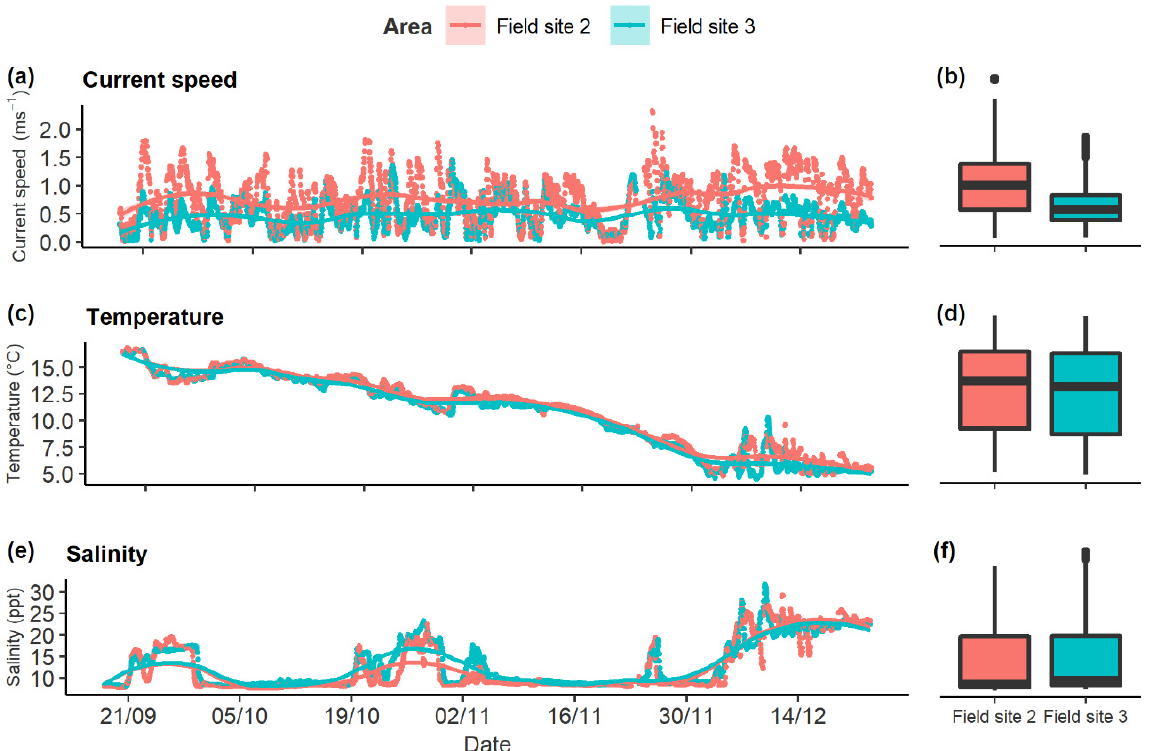
Figure 2. Environmental variables across the study period (September to December 2014) in the mussel reef areas with high currents (HC) (red color) (field site 2) and with low currents (LC) (green color) (field site 3): ( a ) water current speeds (m s − 1 ); ( c ), water temperature ( ◦ C); ( e ) water salinity (ppt); ( b , d , f ) boxplots representing the mean values of the environmental parameters ( a , c , e , respectively) for each site with 95% confidence intervals. The environmental data are derived from a numerical operational model, which estimates the hydrographic conditions in the Øresund basin (Western Baltic Sea). The database Baltic Sea Analyses Forecast was used, accessible via COPERNICUS (https://marine.copernicus.eu/, accessed on 16 November 2021).